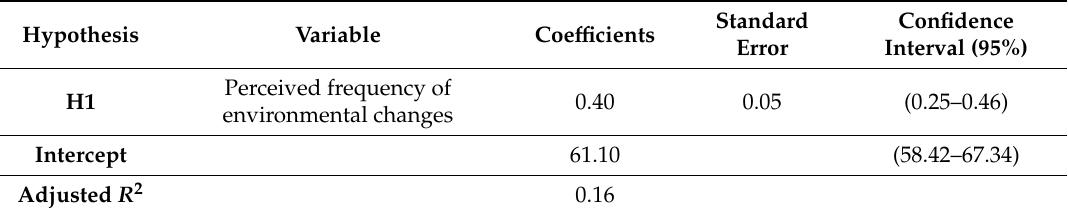
Table 2. Specifications of the linear regression of felt impacts as a function of perceived frequency of environmental changes